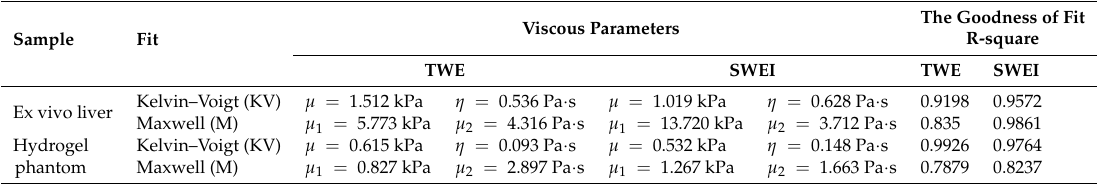
Table 5. Viscoelastic parameters for ex vivo liver samples and hydrogel phantoms obtained from torsional wave elastography (TWE) and shear wave elastography imaging (SWEI) techniques. The Goodness of Fit Viscous Parameters R-square Sample Fit TWE SWEI TWE